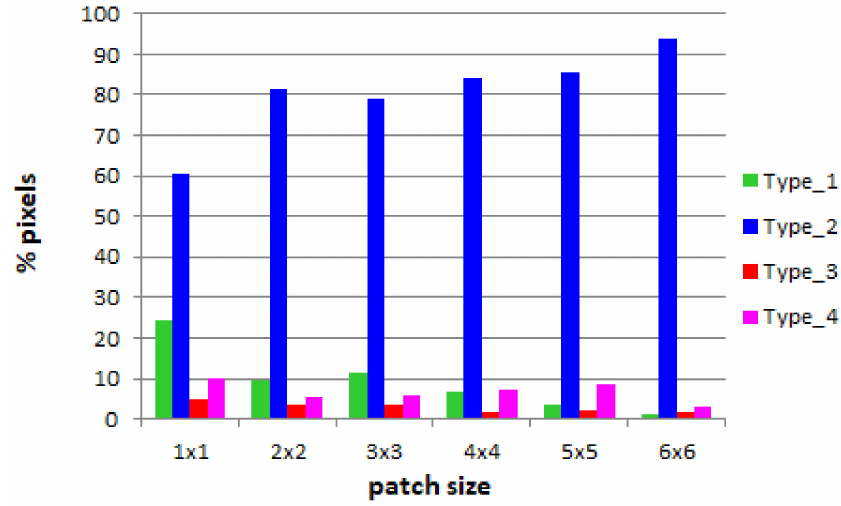
Figure 12. Bar graph for percentage of pixels mapped for the different patch